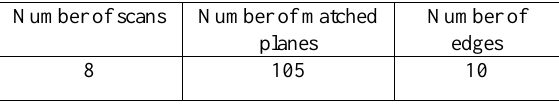
Table 1. Description of the experiment. Table 1 indicate that the plane-based algorithm found 105 correspondences. Figure 5 shows the pairs of point clouds used in the pairwise registration task.